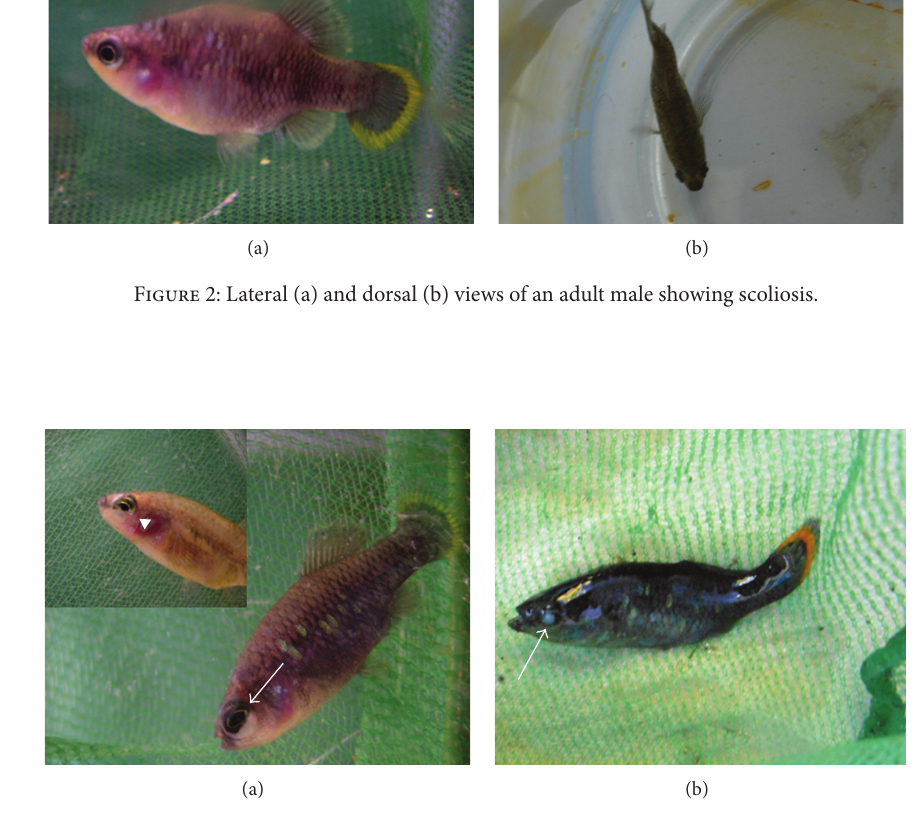
Figure 3: Adult male (arrow) and female (inset, arrowhead) fish with a similar congenital deviation of left ocular axis (a); adult male with left corneal opacity (arrow) and diffuse dark colour (b).